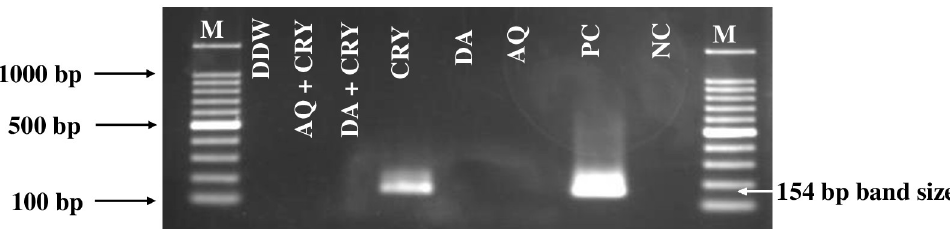
Fig 5. Molecular detection of parasite DNA in the blood of treated groups. The image shows the molecular detection of parasites in the blood of treated groups on day 49. M indicates the marker, NC indicates the untreated-uninfected group used as a negative control, and PC indicates the untreated-infected group used as the positive control. The arrow shows the expected band length of 154 bp for positive cases of B . microti